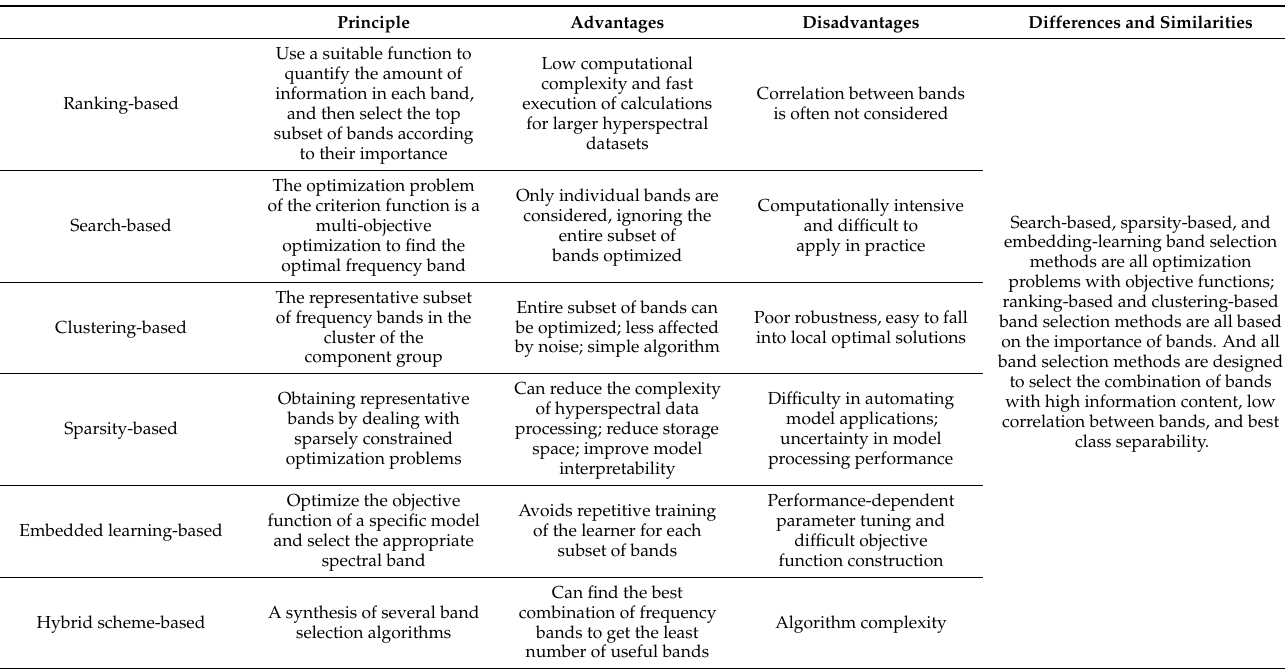
Table 2. Comparison of six band selection